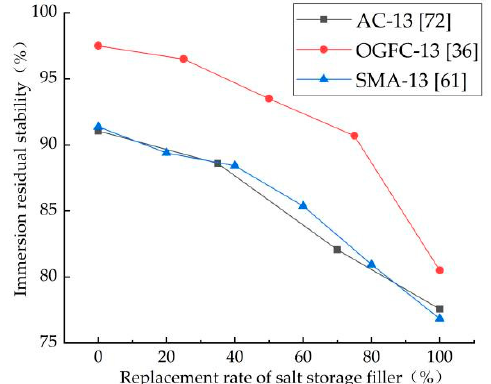
Figure 8. The immersion Marshall test of the different types of salt-storage mixtures. (Sun 2012 [36], Guo 2017 [61], Xu, et al. [72]).